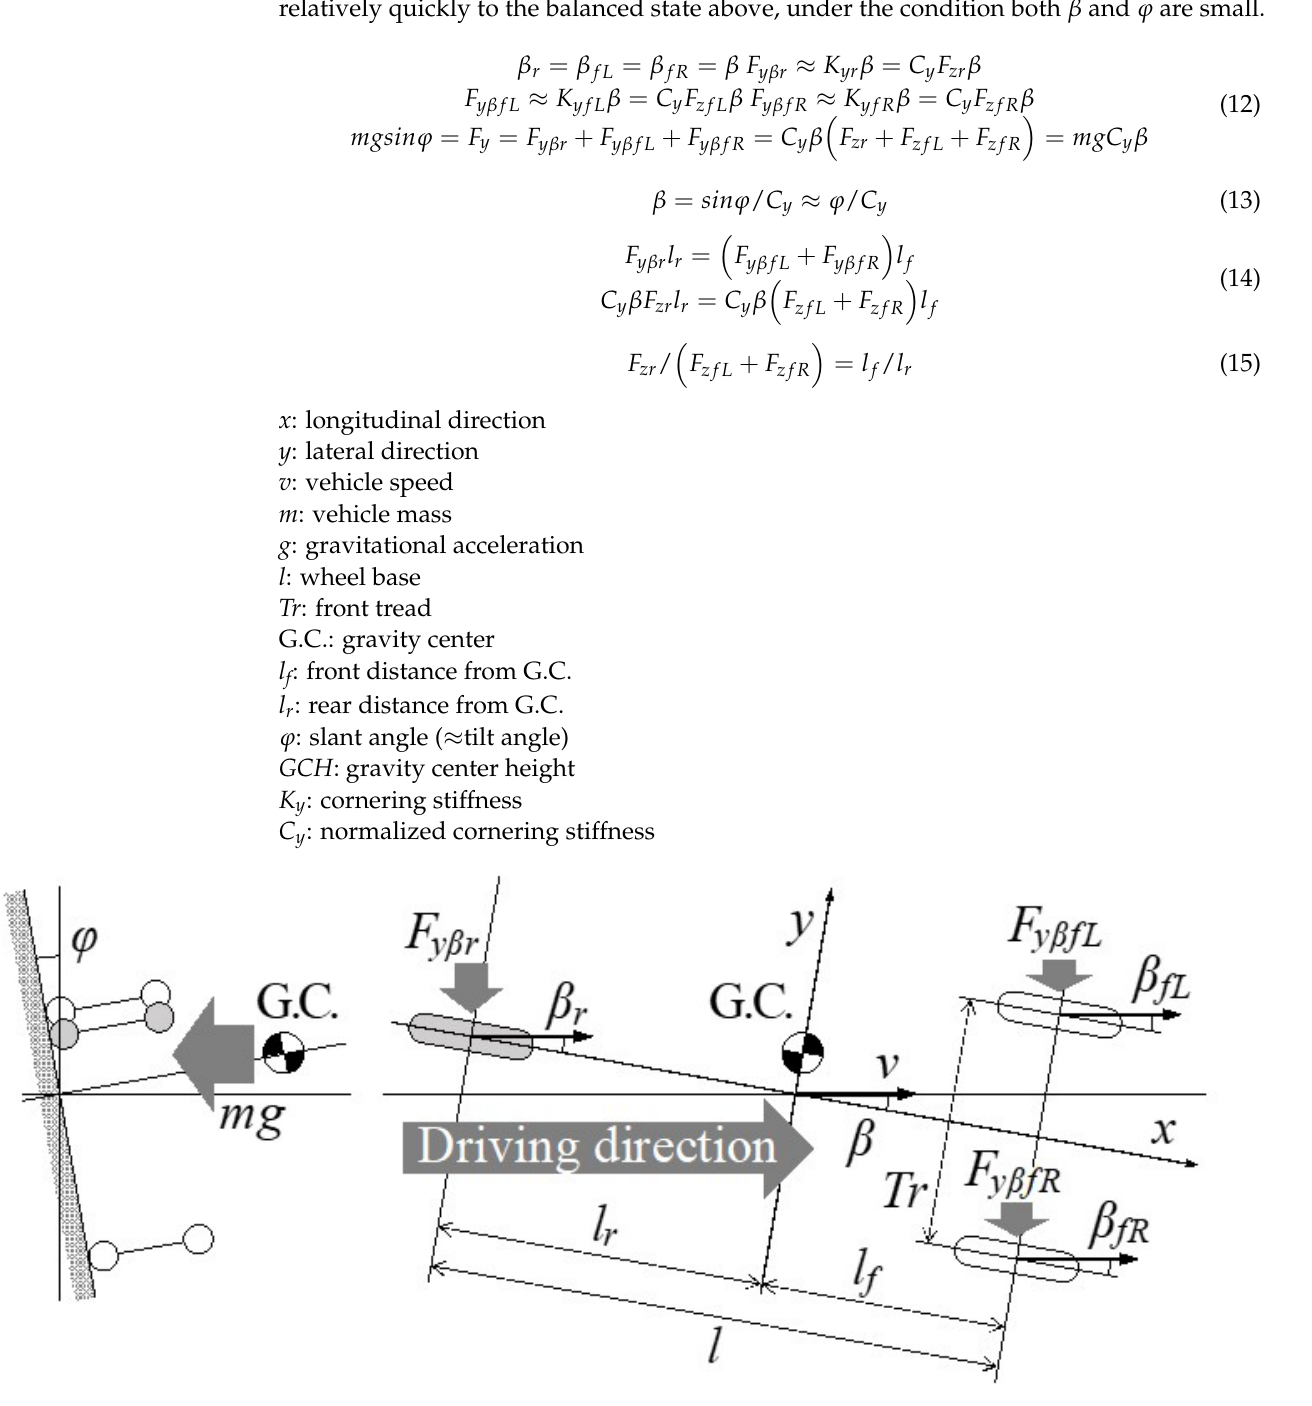
Figure 14. Straight running on a slanted road without inward tilting